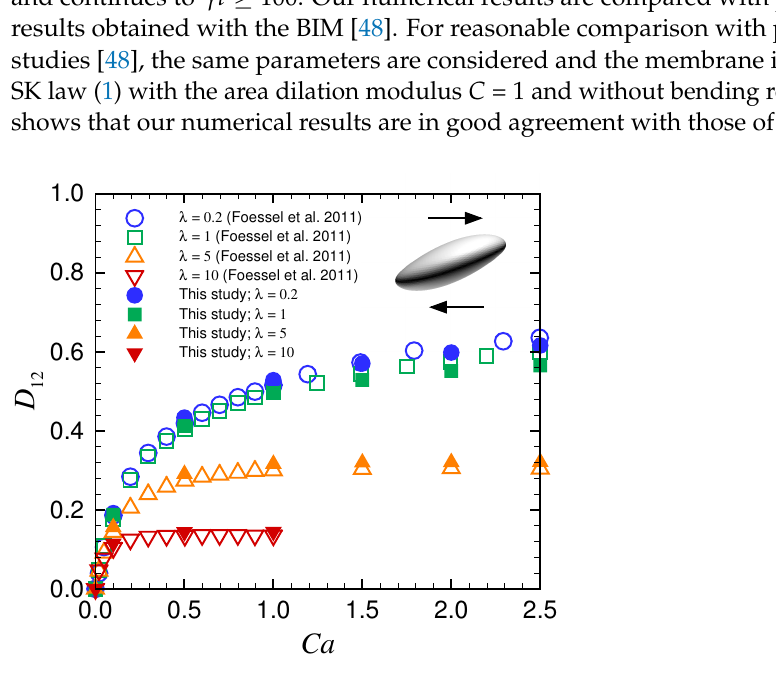
Figure A1. Time-averaged Taylor parameters D 12 of an SK spherical capsule as a function of Ca for different viscosities λ (0.2, 1, 5, and 10); previous numerical results of Foessel et al. [48] are also displayed. The inset represents a tank-treading spherical capsule at Ca = 1.0 and λ = 1. The results were obtained with Re p =